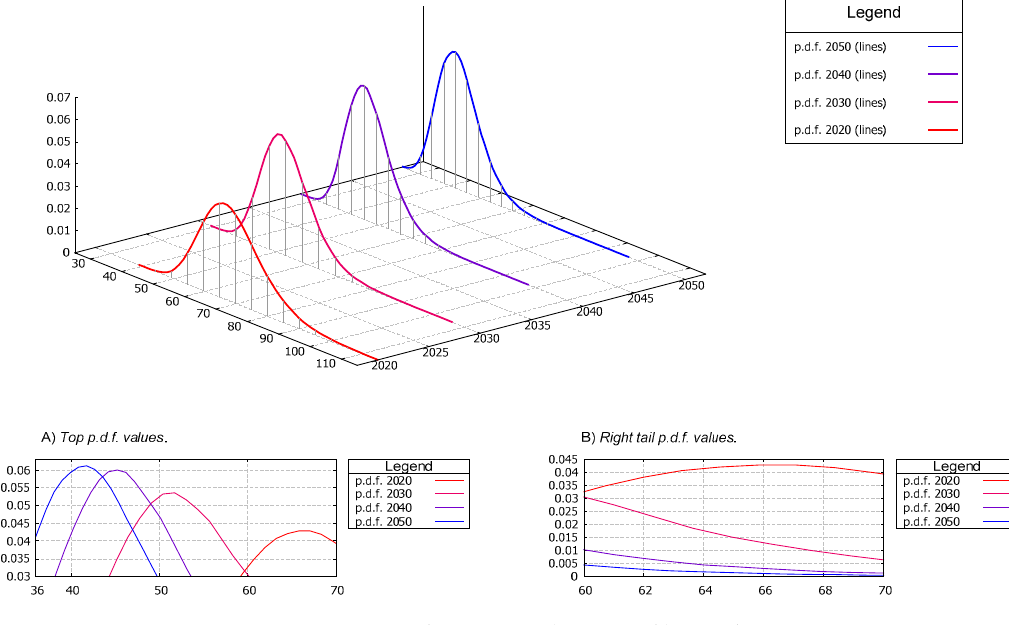
Figure 3. IEA roadmap LCOE (USD/MWh): Timeline.